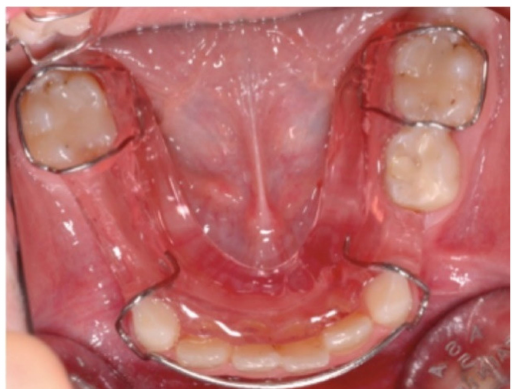
Figure 1. Example of orthodontic device aimed at maintaining space in the dental arch.